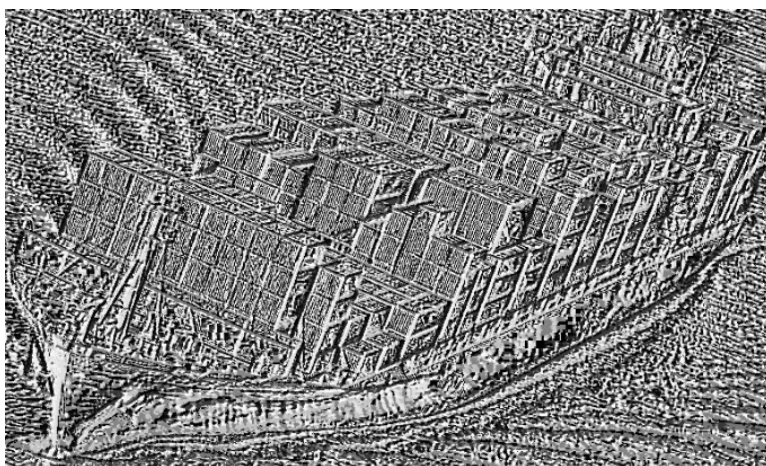
Figure 6. LBP texture image of the ship.